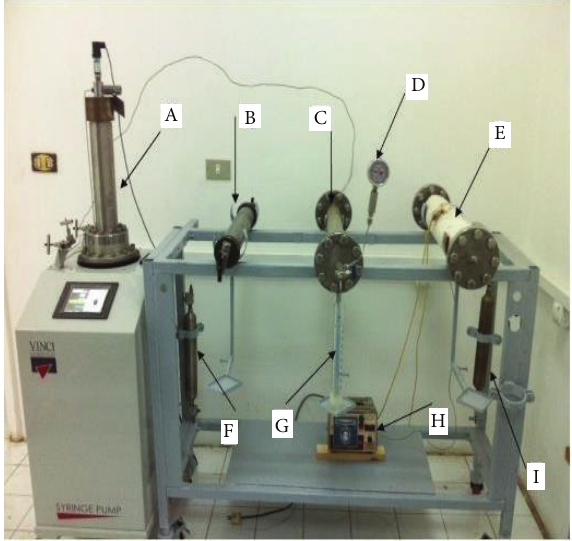
Figure3:Displacementfloodapparatus(A:pump;B:brinesolution; C: sandstone holder; D: pressure gauge; E: sandstone holder with heating jacket; F: HAPAM solution; G: measuring cylinder; H: electrical heating unit; I: HAPAM solution).